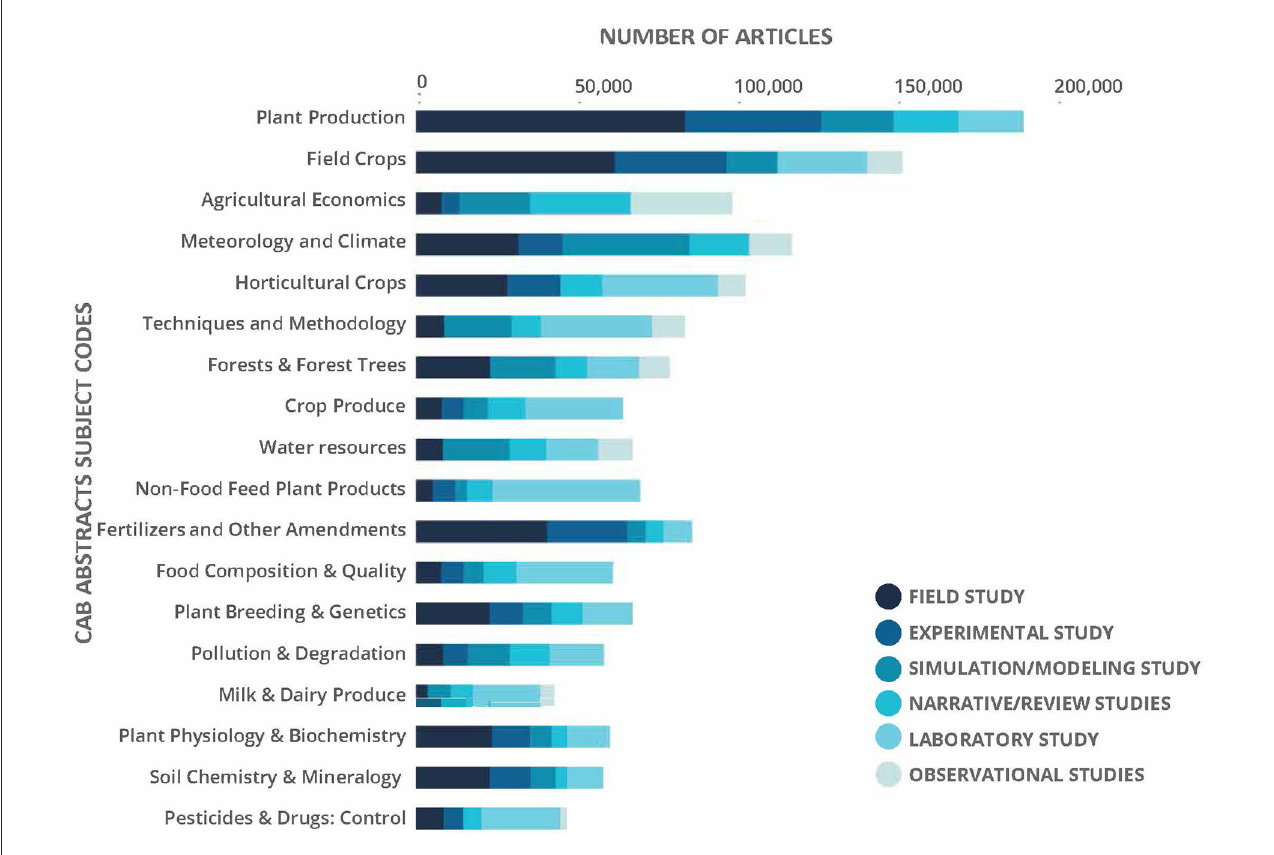
FIGURE4 Study design and research topic